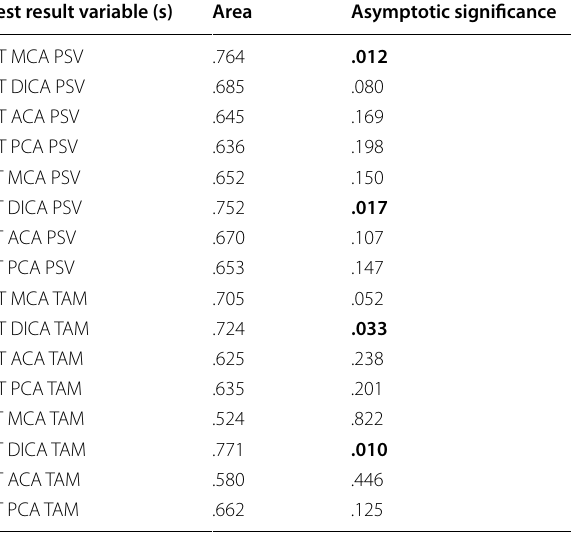
Bold indicate significat values and to highlight their importance